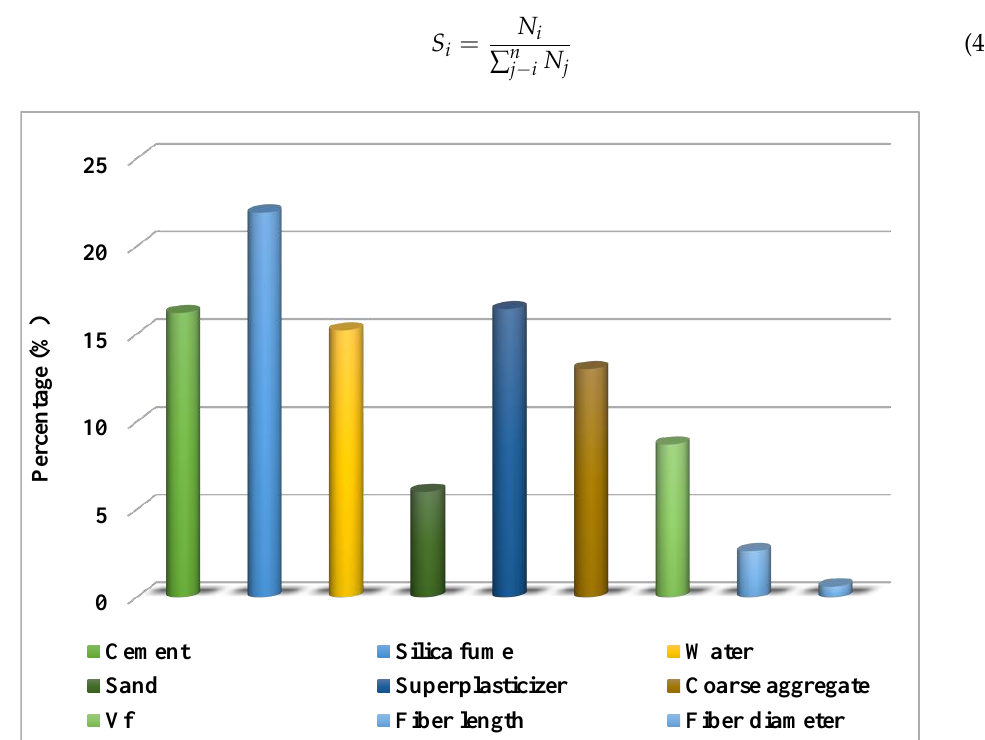
Figure 12. The input variable contribution to the forecast. Cement, water, superplasticizer, silica fume, coarse aggregate, sand, Vf (volume factor), fiber length, and fiber diameter.